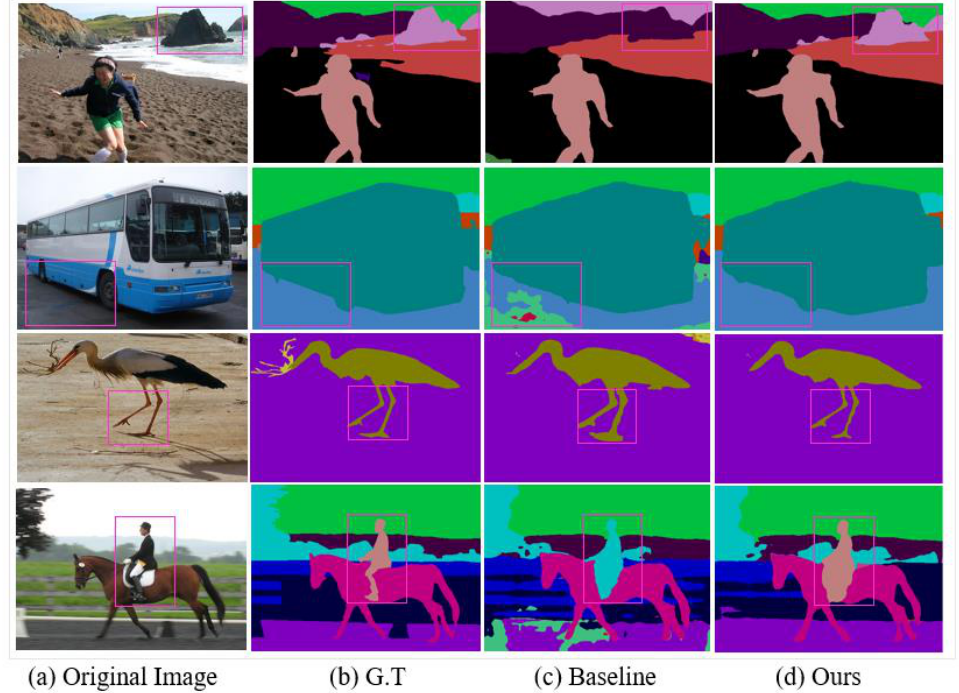
Figure 7. Visual improvements on Pascal-Context dataset. Our method well considers boundary information. Consequently, produces more accurate and detailed results.